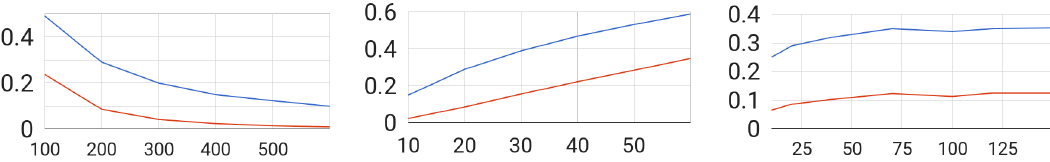
V W , k , and increase ( x -axis). | | | |